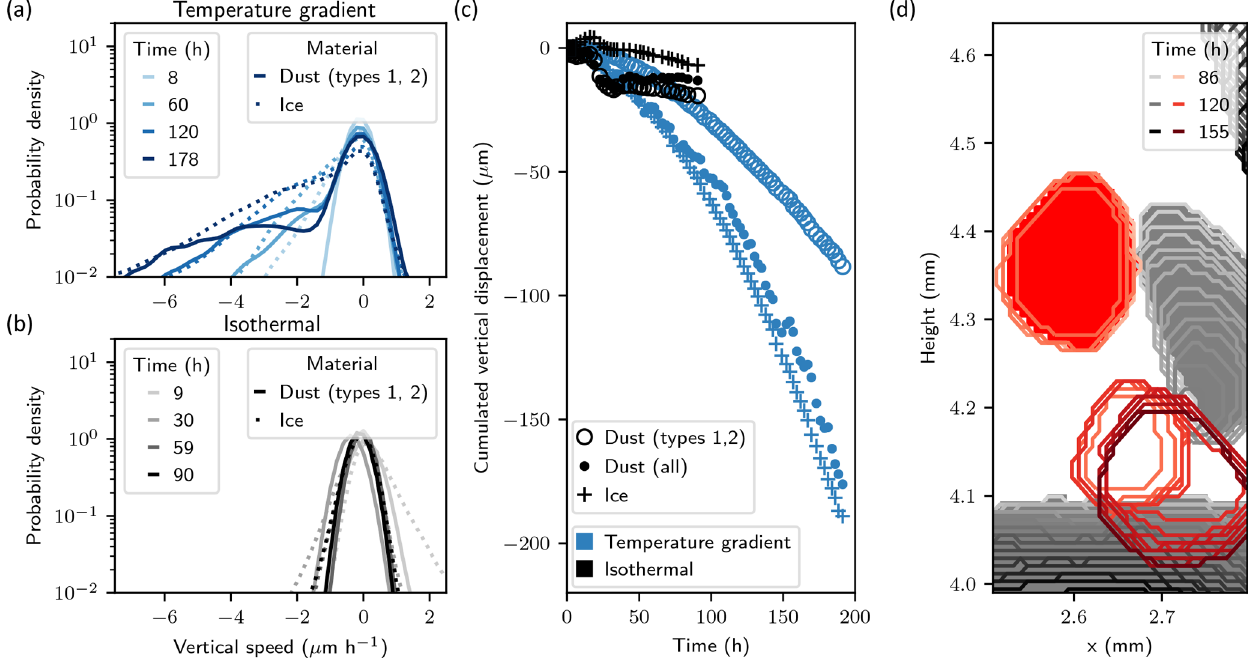
Figure 4. Dust downward movement. (a, b) Distribution of the dust particle and ice surface vertical velocities. The probability density is expressed in terms of number of particles and is computed with bins of width 0.02µmh − 1 . (c) Mean vertical velocity of the ice surface and of dust computed with all dust particles or only those with moderate displacements (types 1 and 2). (d) Example of a particle movement of type 3: sudden fall by loss of contact to ice and then progressive downward movement with the sublimating ice surface.